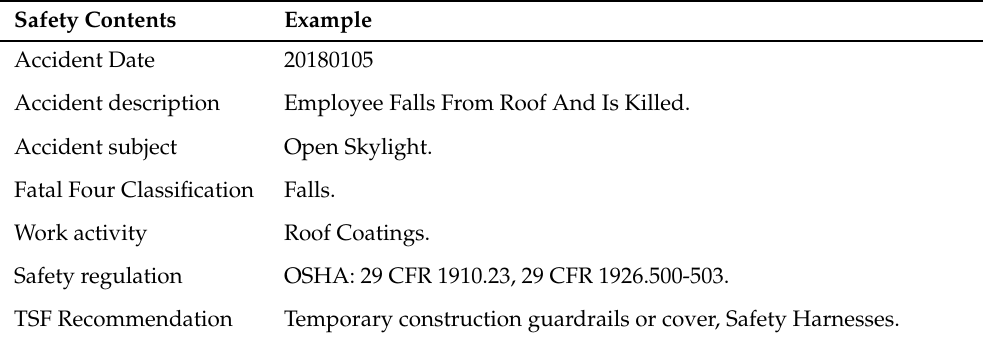
Table 2. Example of data obtained from FFA